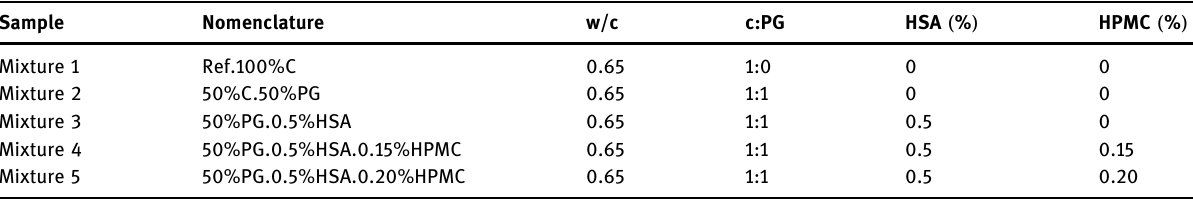
Table 2: Mixture proportions: mini - cone , calorimetry, and rheometry Sample